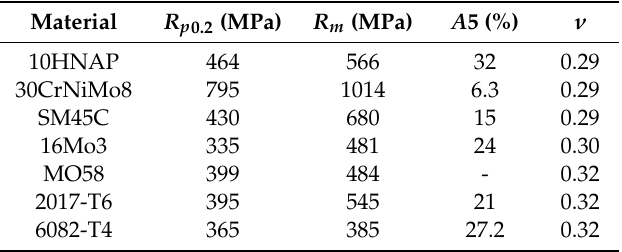
Table 2. Mechanical properties of the tested and analyzed materials, such as o ff set yield point ( R p0.2